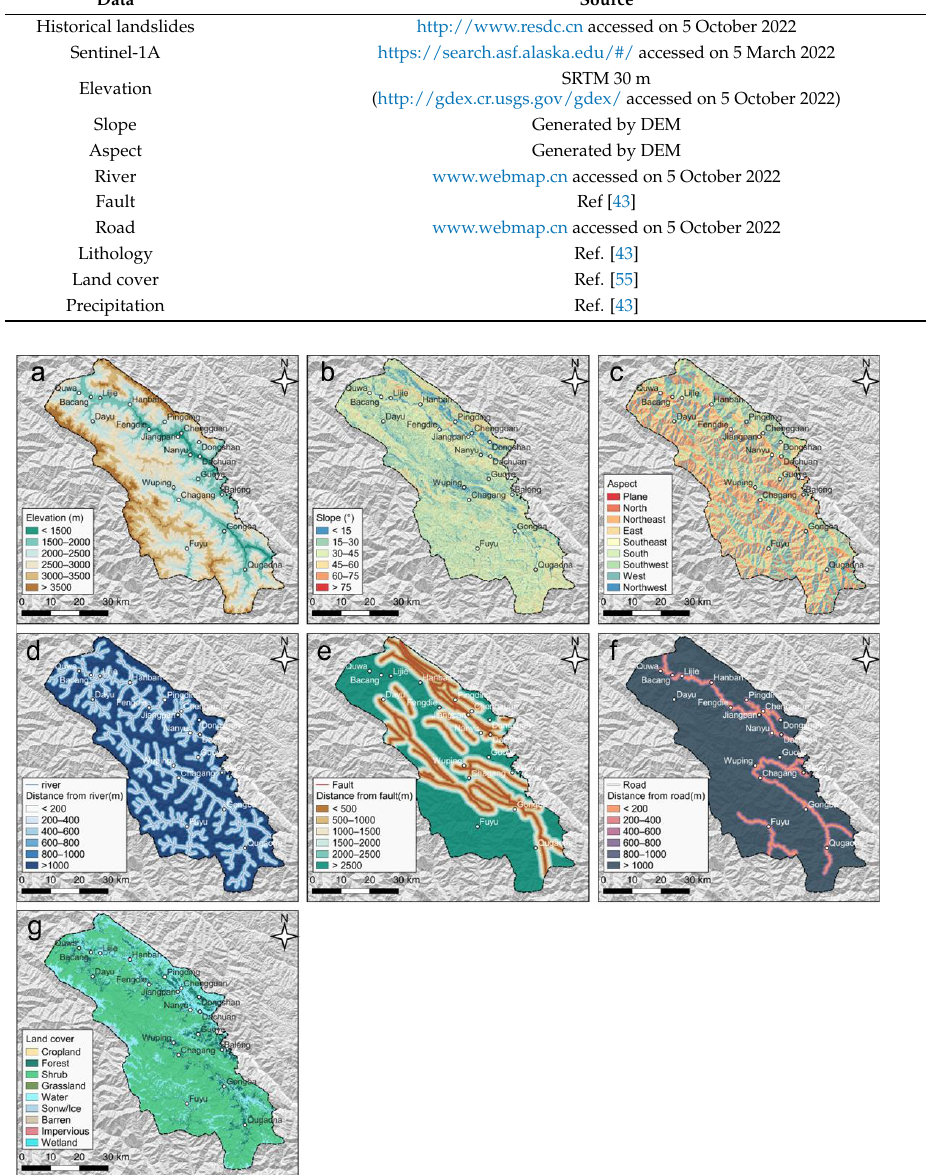
Figure 8. Landslide hazard factor classification in Zhouqu: ( a ) elevation; ( b ) slope; ( c ) aspect; ( d ) distance from river; ( e ) distance from fault; ( f ) distance from road; and ( g ) land cover. Table 5. CF values obtained for different classes of the seven factors influencing landslides in Zhouqu.